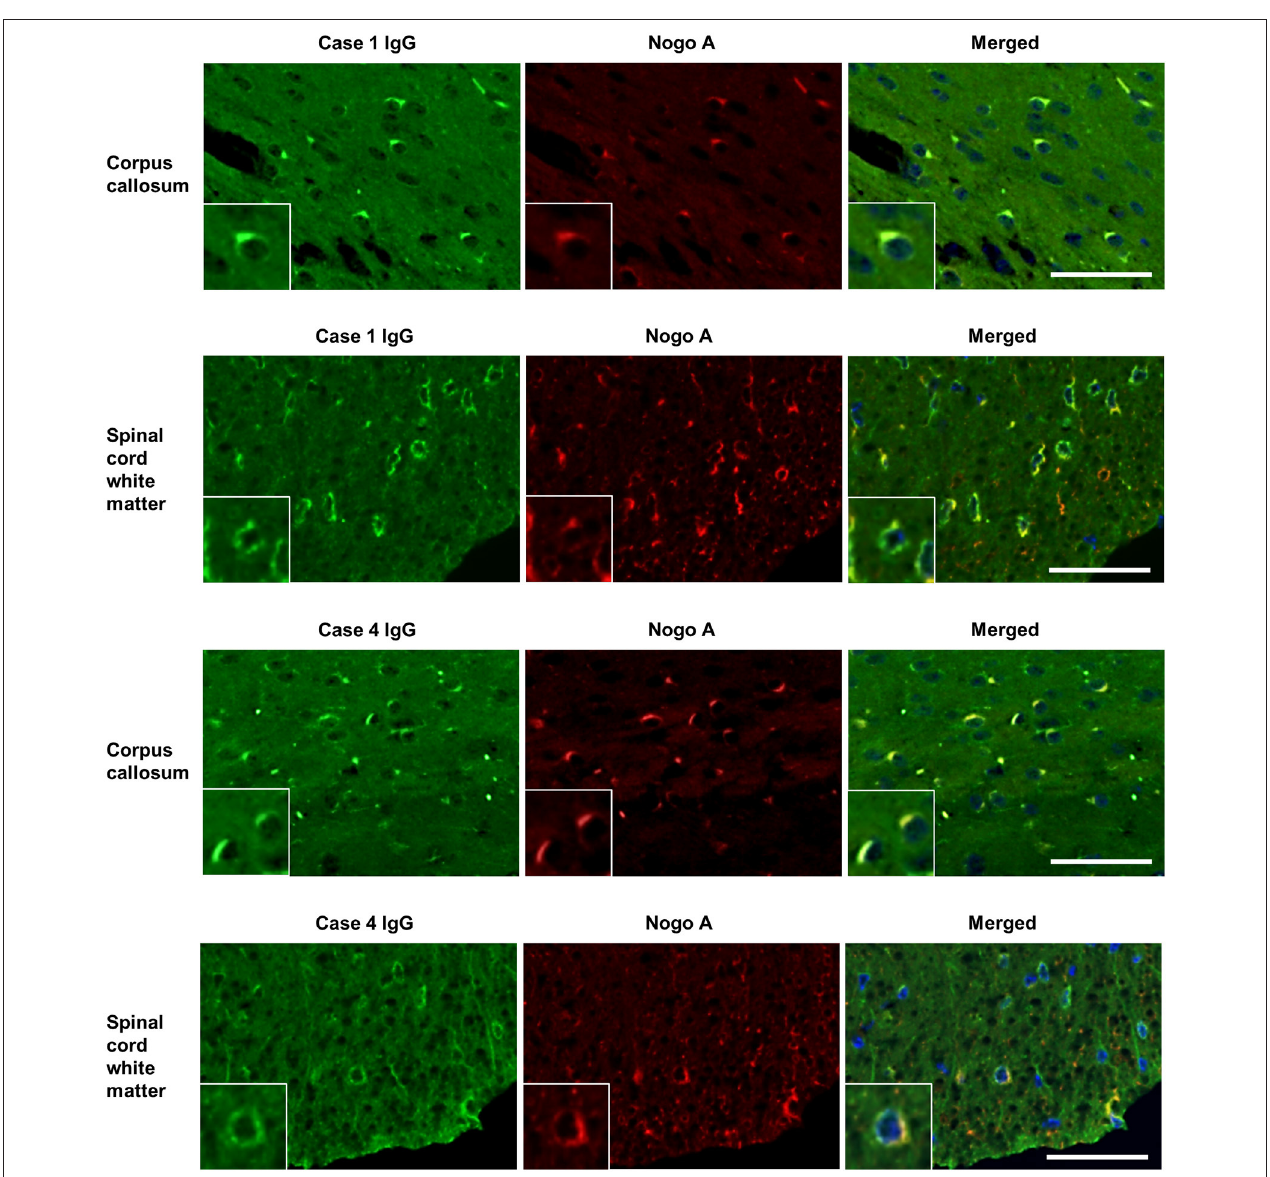
FIGURE 2 | Dual immunostaining of mouse cerebrum and spinal cord using patient IgG and anti-Nogo A antibodies. IgGs (green) from one representative PPMS patient (Case 1) and one SPMS patient (Case 4) bound to Nogo A-positive oligodendrocytes (red) in mouse corpus callosum and spinal cord white matter. Scale bar = 50 µ m. IgG, immunoglobulin G; PPMS, primary progressive multiple sclerosis; RRMS, relapsing–remitting multiple